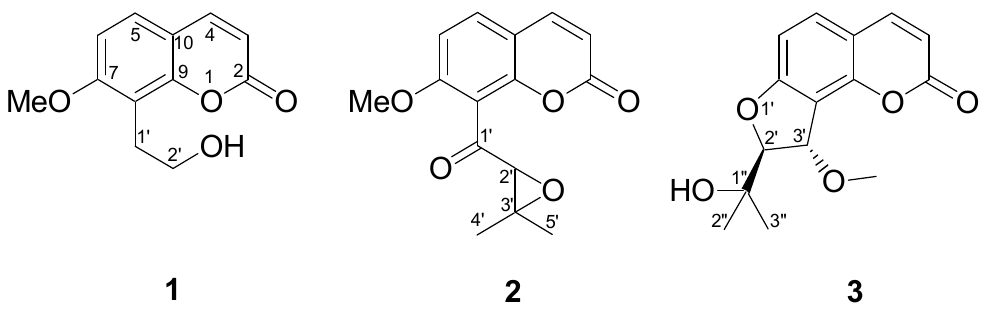
Figure 1. The chemical structures of new compounds 1 – 3 isolated from Cnidium monnieri